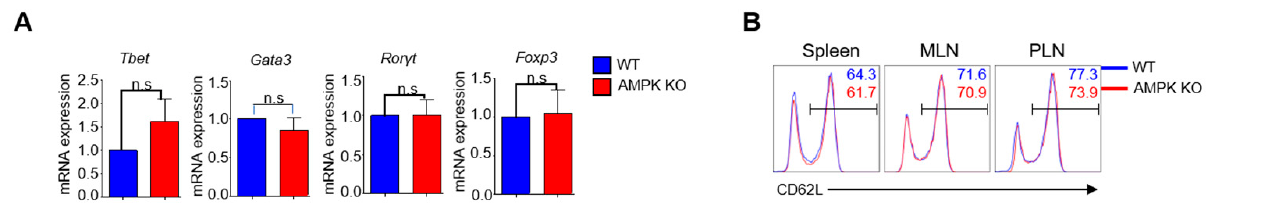
Figure 1. The phenotypes of young AMPK α 1 fl/fl Foxp3 YFP-Cre (AMPK-KO) and Foxp3 YFP-Cre (WT) mice were similar. ( A ) Detection of mRNA expression of the Tbet , Gata3 , and Ror γ t from CD4 and Foxp3 from regulatory T cells (Tregs) isolated from WT and AMPK-KO mice by real-time PCR. The data were normalized to Gapdh gene expression. ( B ) Flow cytometric analysis of CD62 hi CD44 lo percent- age in CD4 isolated from WT and AMPK-KO mice. ( C ) MFI representatives of CD69, CD39, CD132, CD122, CD28, CXCR5, CCR1, and CCR6 in CD4 isolated from WT and AMPK-KO mice. ( D ) The percentage of immature and mature thymic Tregs in WT and AMPK-KO mice. ( E ) Flow cytometric analysis of the MFI of the helios in Tregs from WT and AMPK-KO mice. ( F ) Flow cytometric analysis and MFI representatives of CD25 in Tregs from the thymus, mesenteric lymph nodes (MLNs), pe- ripheral lymph nodes (PLN), and spleen from WT and AMPK-KO mice. ( G ) MFI representation of the flow cytometric analysis of PD-1 in Tregs from the spleen of WT and AMPK-KO mice. n.s means non-significant ( p > 0.05). 2.2. Young AMPK-KO Mice Showed a Less Inflammatory Phenotype Than WT Mice Several studies have described how AMPK activation can inhibit the inflammatory response, whereas decreased AMPK activity is associated with increased inflammation [15,16]. To determine the role of AMPK in Tregs in inflammation in young mice, we used the experimental autoimmune encephalomyelitis (EAE) model, a well-established mouse model for multiple sclerosis. Accordingly, EAE was induced in mice by immunization with the MOG 35–55 peptide in CFA and pertussis toxin, as explained in Section 4.2. Inter- estingly, young AMPK-KO mice showed low disease severity, as indicated by decreased clinical scores (Figure 2A). Furthermore, we isolated the brain and spinal cord from EAE- induced WT and AMPK-KO mice and analyzed CD4 + and CD8 + T cell infiltration to eval- uate immune cell infiltration in nervous tissues. CD4 + T and CD8 + T cells infiltrated the spinal cord of WT mice more than the spinal cord of AMPK-KO mice (Figure 2B,C), but not the brain tissues (Figure 2B,C). Previous studies have reported that Th1 and Th17 cells are critically involved in the pathogenesis of multiple sclerosis and its mouse model, EAE [17–19]. Therefore, we examined TH1 and TH17 cell infiltration by intracellular staining of mononuclear cells derived from the spinal cord and lymph nodes. Supporting the pre- vious result, IFN- γ -specific Th1 cells significantly reduced in the spinal cord and lymph nodes of AMPK-KO mice (Figure 2D). Collectively, these findings indicate that AMPK- KO mice show less EAE than WT mice by reducing T cell infiltration in the spinal cord.